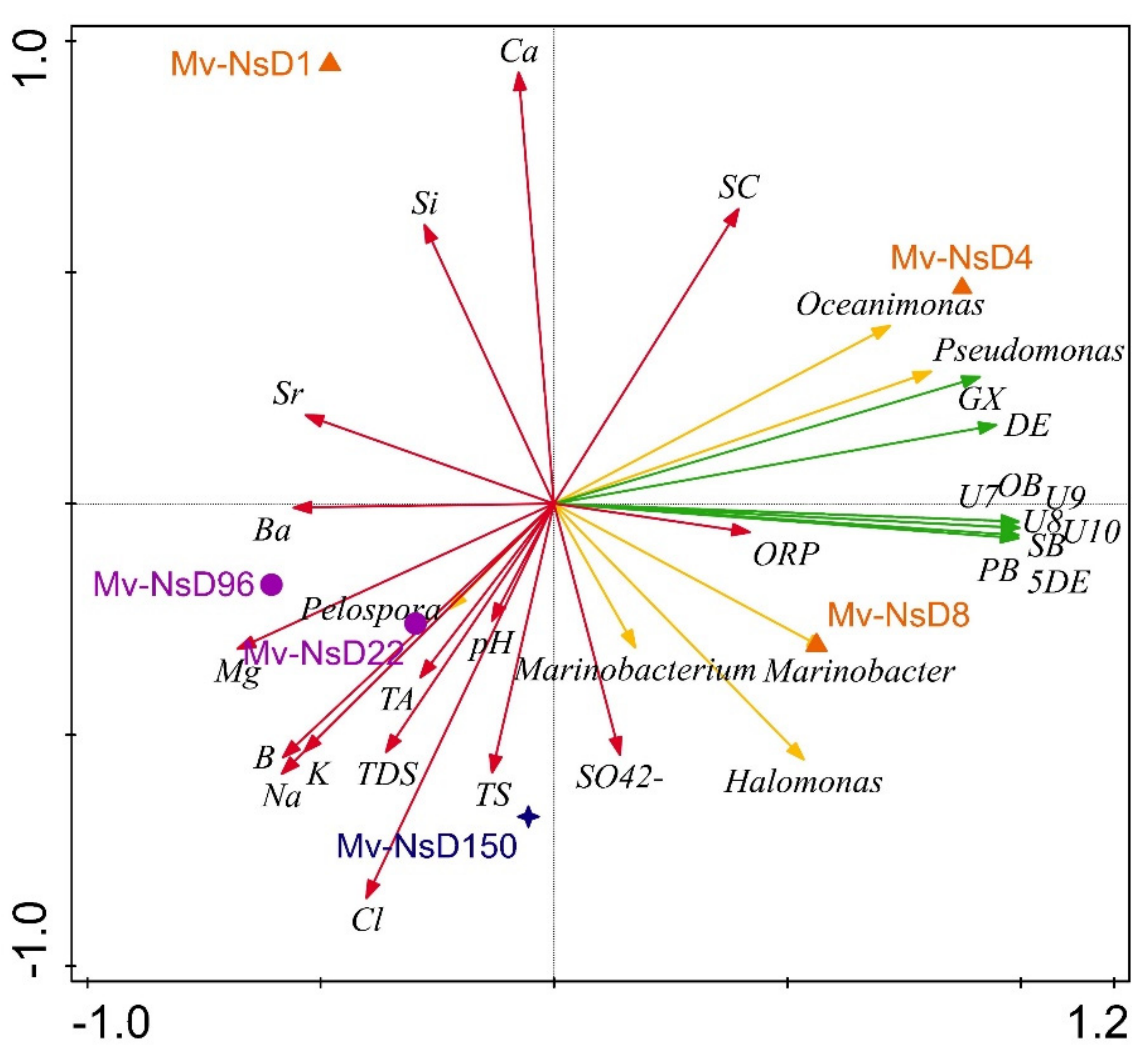
Figure 9. PCoA ordination triplots denoting the relationship of bacterial genera (yellow arrow), functional pathways (green arrow), and physicochemical properties of the samples (red arrow) with the sampling period (orange triangles denote the initial period, purple circles denote the mid period, and blue stars denote the long period) using CANOCO 5. Arrows indicate directions of maximum variation of environmental variables; the length of the arrows indicates their importance. Abbreviations used in the figure are as follows: 5DE: (5Z)-dodec-5-enoate biosynthesis; PB: palmitoleate biosynthesis